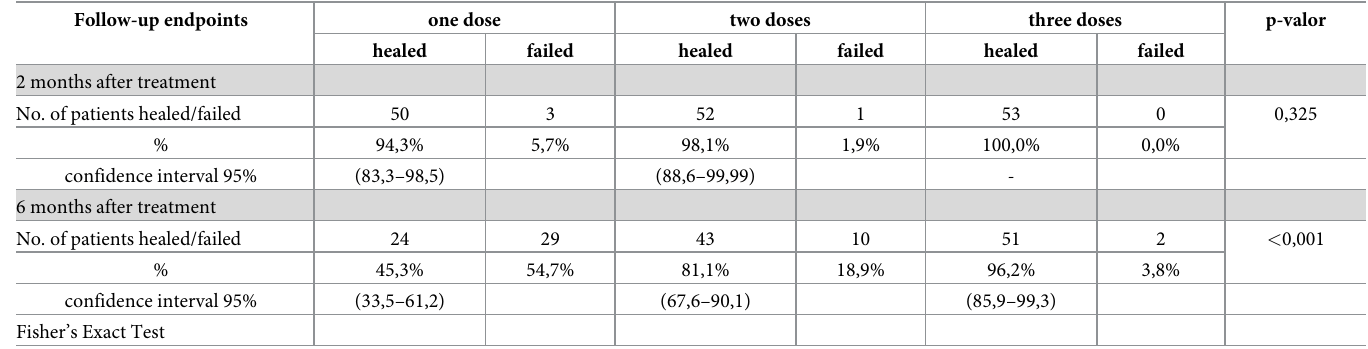
Table 2. Follow-up endpoint results in treatment groups.